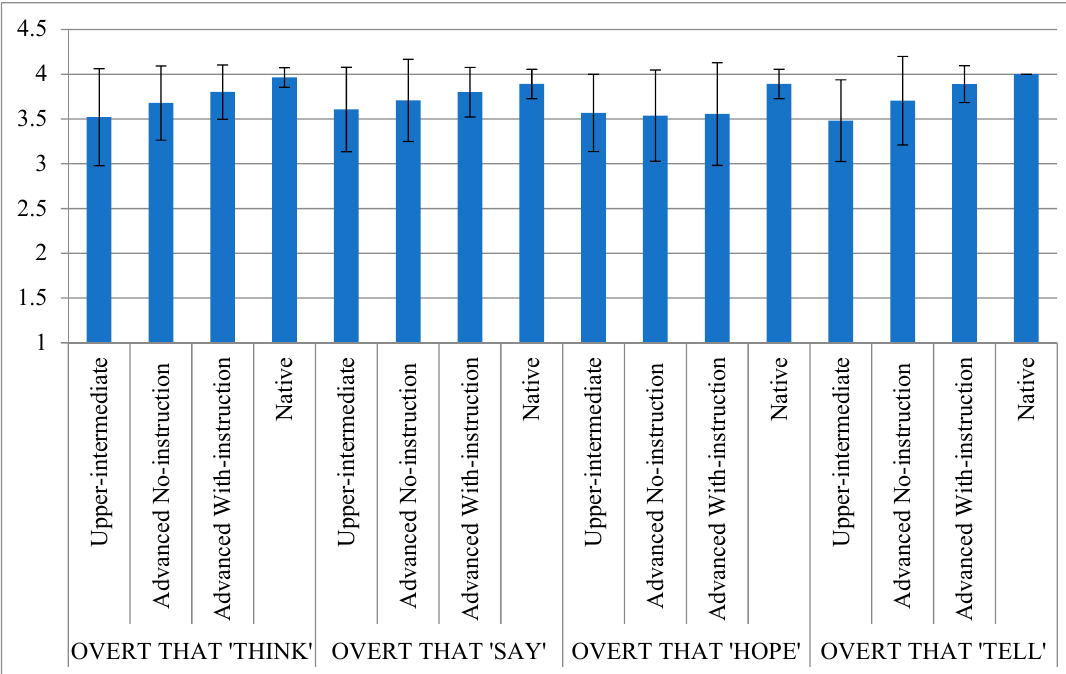
Figure 3. Acceptability rates by group and verb. Overt that condition.